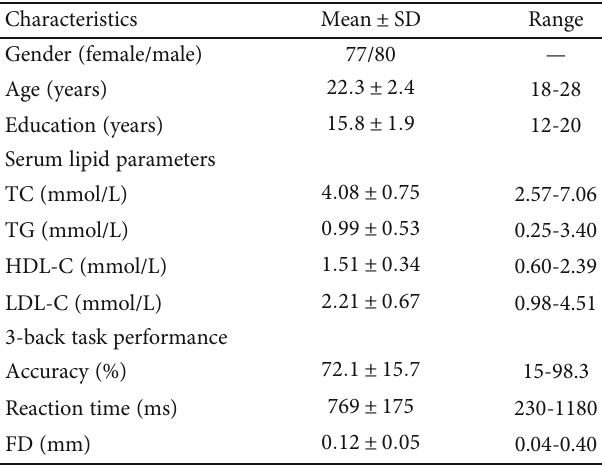
Table 1: Demographic, behavioral, and serum lipid data of 157 healthy